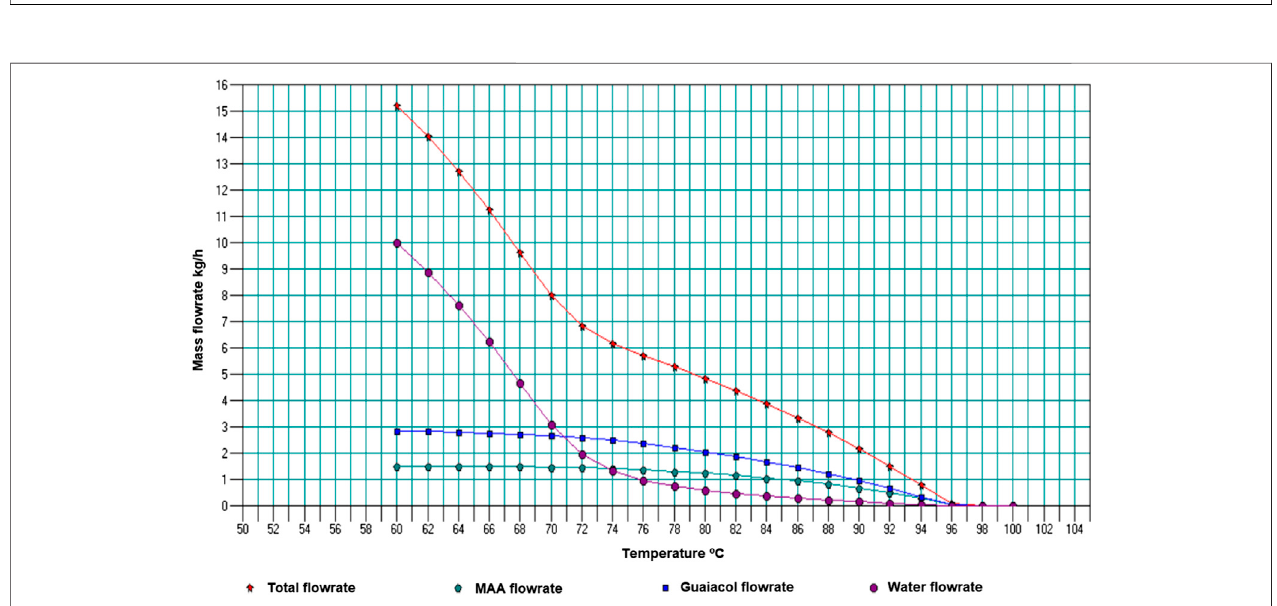
FIGURE 4 | Product component fl ow rates with variation of secondary condenser temperature.